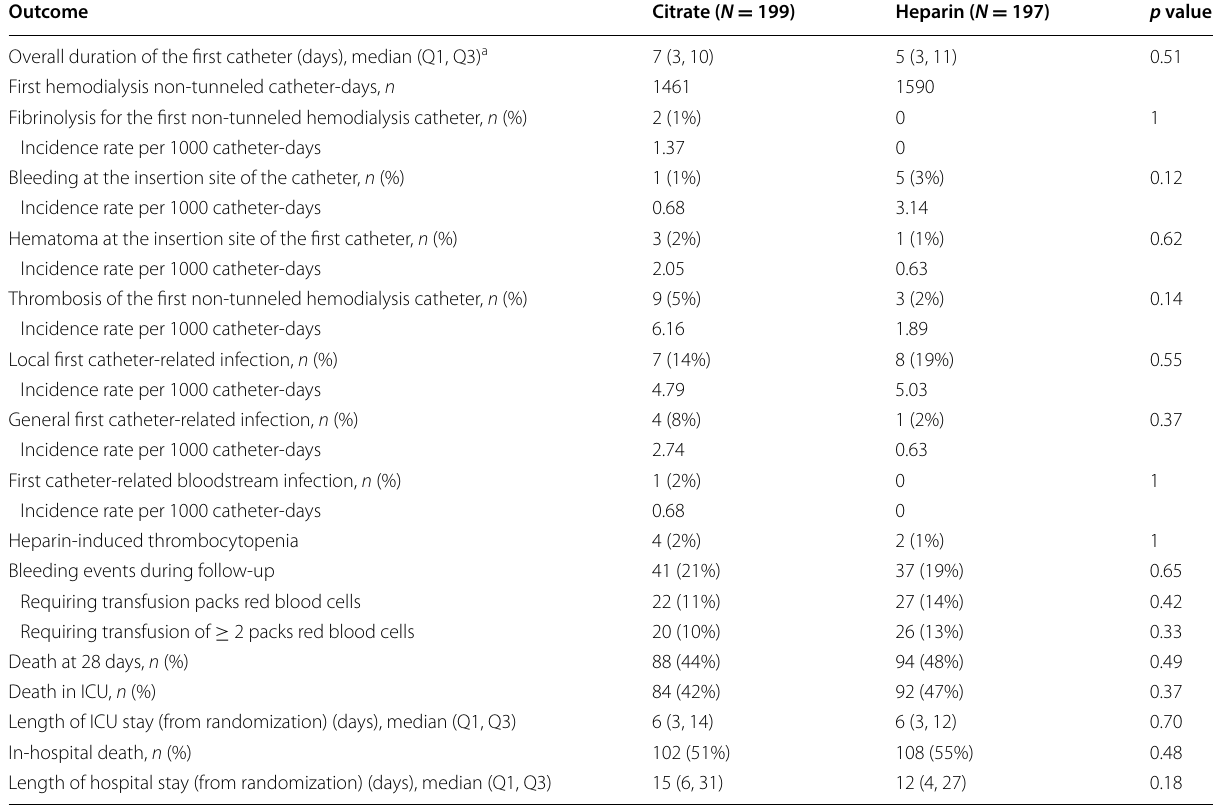
a Kaplan–Meier estimation and log-rank test with one missing data in the Heparin arm